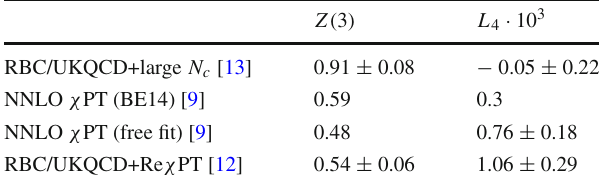
Table 9 Correlation of Z and L 4 in available determinations of F